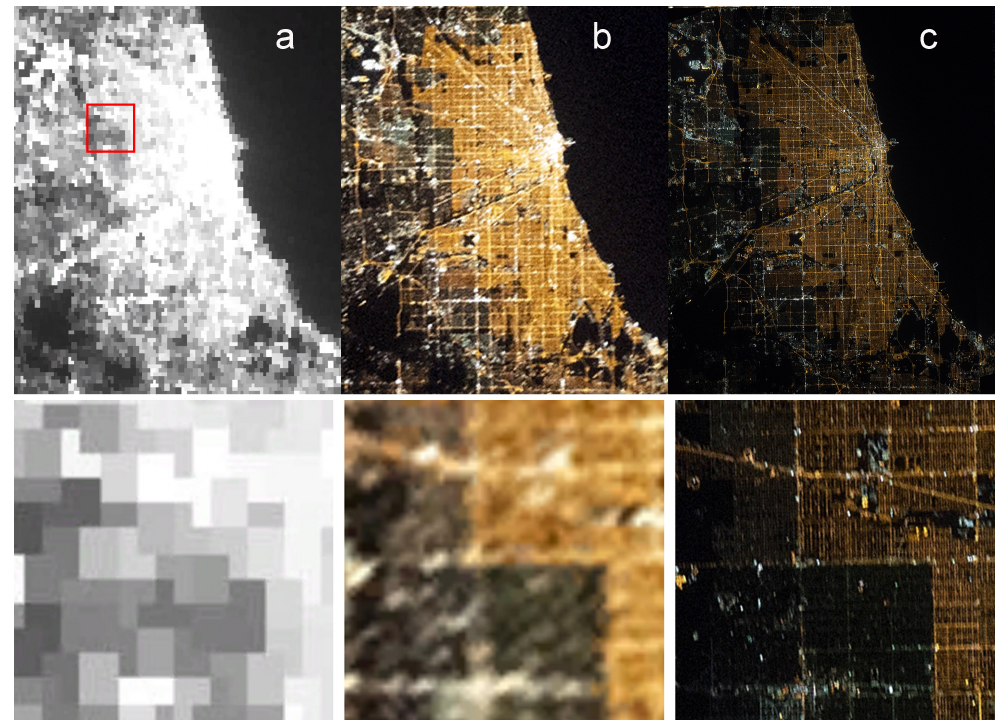
Figure 3. Comparison of resolution and color in remotely sensed nighttime images of Chicago. Each image is 39 × 48 km. ( a ) Panchromatic VIIRS-DNB data (14 November 2020) 740 m px 1 ; ( b ) ISS RGB image (ISS050-E-029303) at 100 m px 1 and ( c ) ISS RGB image (ISS046-E-025710) at 25 m px 1 resolution. The red box is the location of the 6x6km insets shown below each image (North is